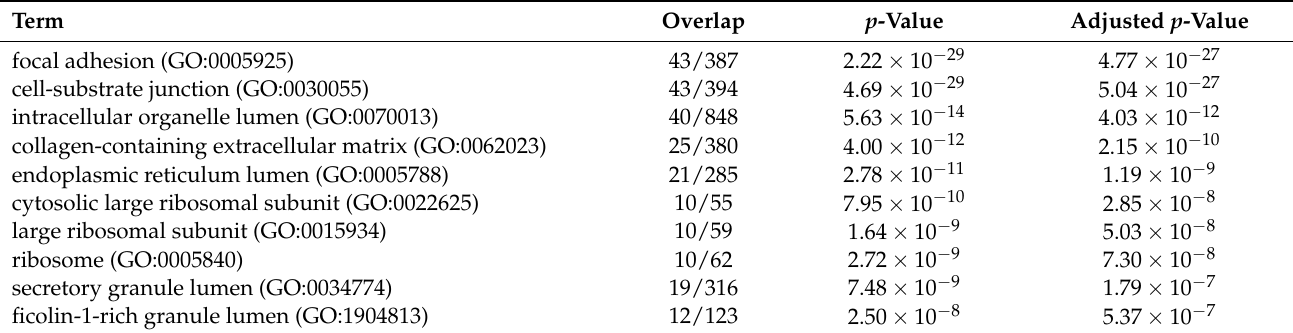
Table 3. The top 10 enriched terms in “GO Cellular Component 2021” using Enrichr. Overlap is the number of common genes between the genes uploaded and the genes in the category divided by the number of genes in the category. Probes, whose associated genes were uploaded to Enrichr, were identified using PCA-based unsupervised